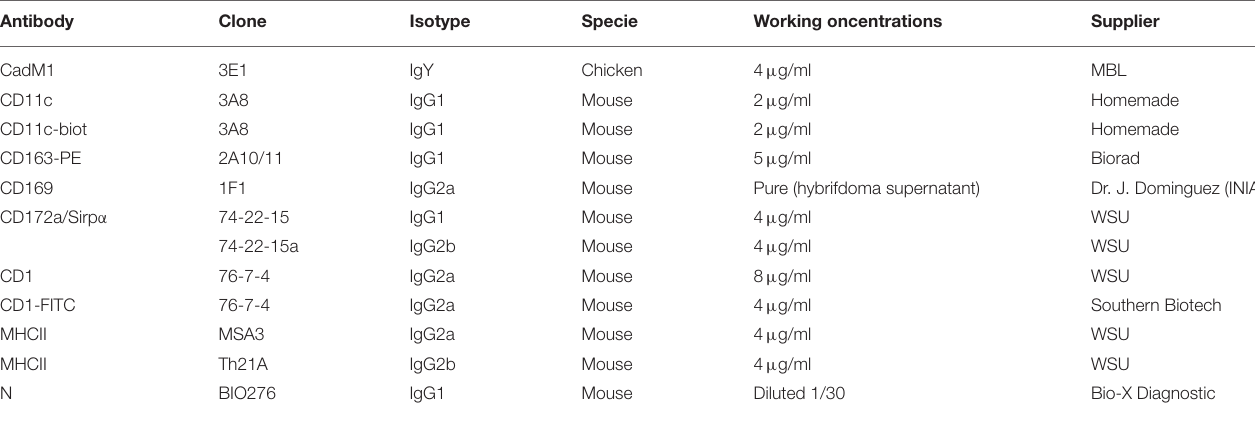
TABLE 1 | Antibodies used for MPC cell sorting and infection analysis by flow cytometry. Antibody